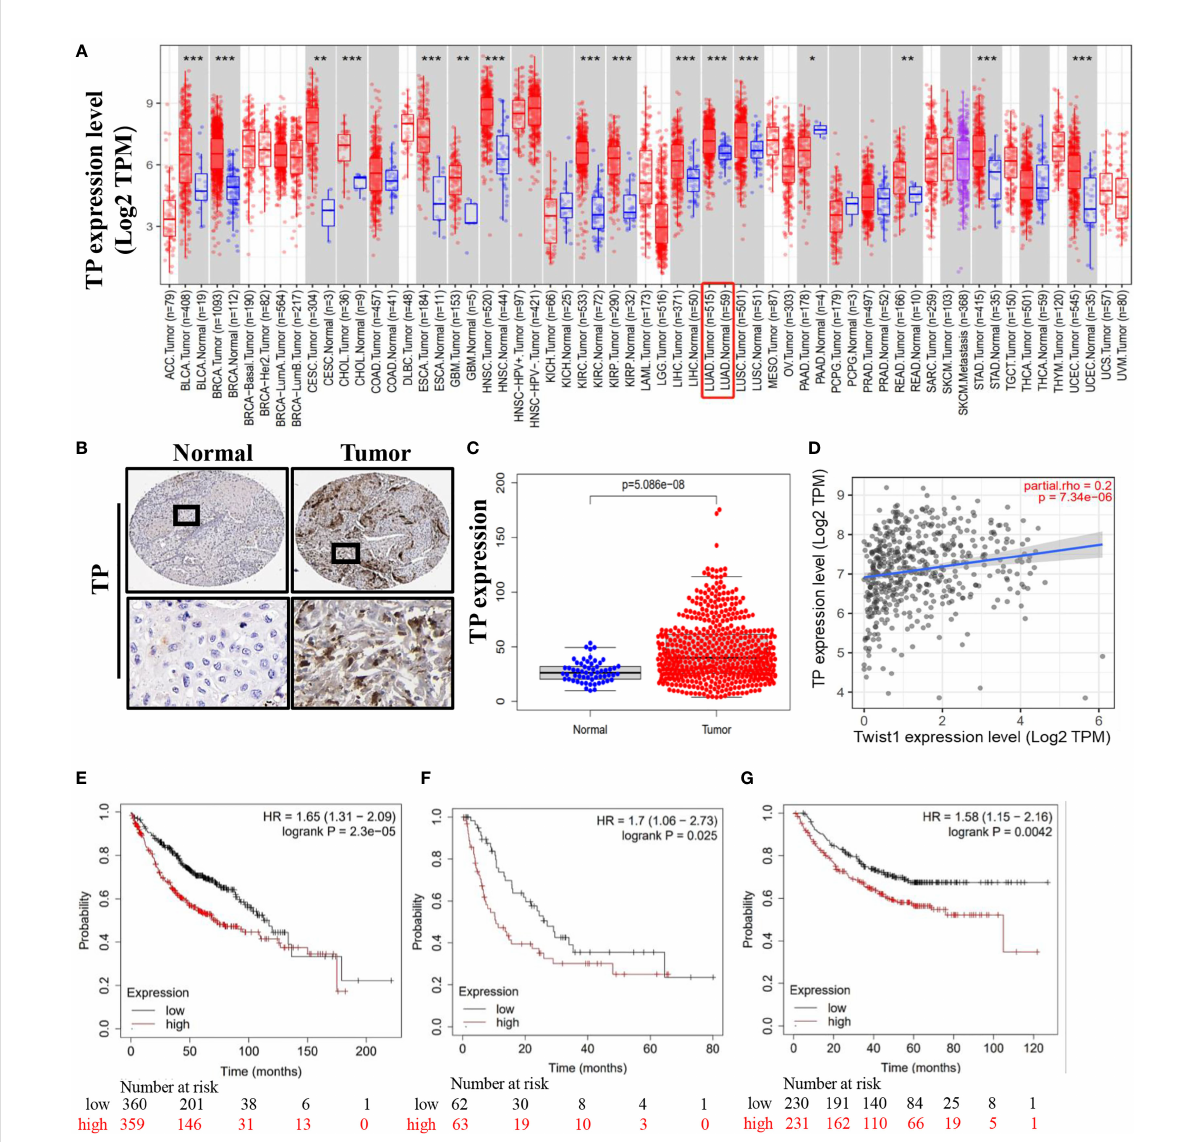
FIGURE 6 Lung cancer patient tissue TP levels as an indicator of poor prognosis. (A) High-level TP expression in lung cancer tissues. (B, C) Representative images derived from immunohistochemical staining of normal and lung cancer tumor tissues showing high tumor cell TP levels. (D) Correlation between TP and Twist1 expression levels. (E) Overall survival (OS). (F) First-progression survival (FP). (G) Post-progression survival (PPS). Data were obtained from the Human Protein Atlas and the TIMER2.0 database. (*P < 0.05 and **P < 0.01 and *** P <